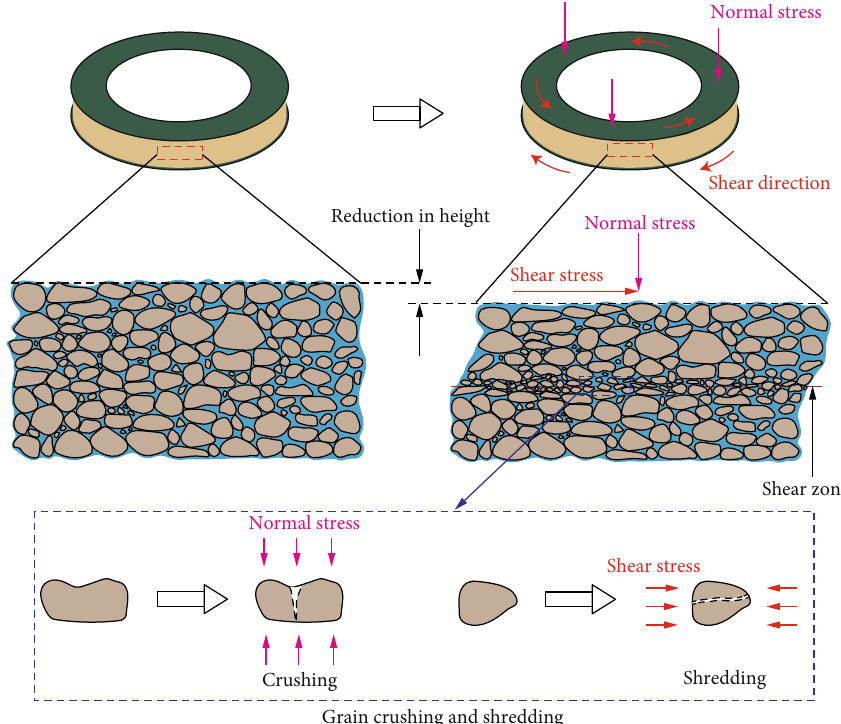
Figure 11: Schematic illustration of grain crushing and height reduction.